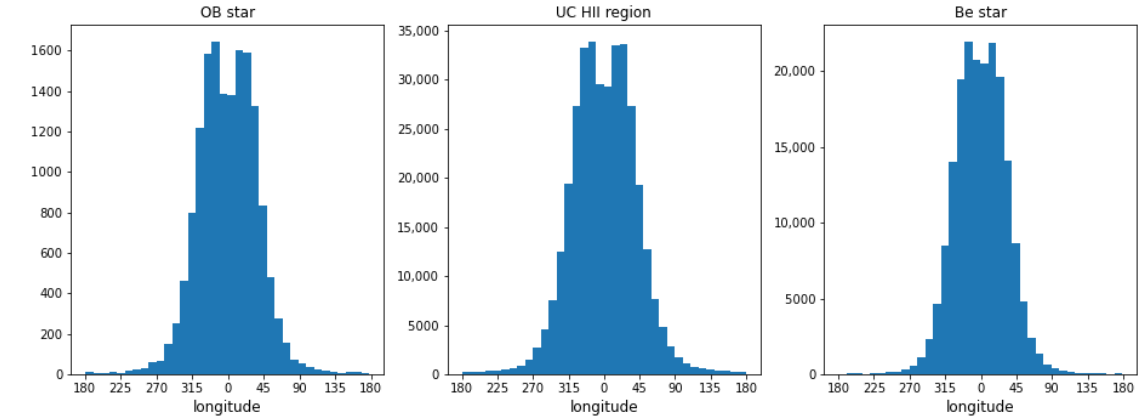
Figure 9. The longitude distribution of detectable OB, Be stars, and UC HII regions above 10 nano-Jy.